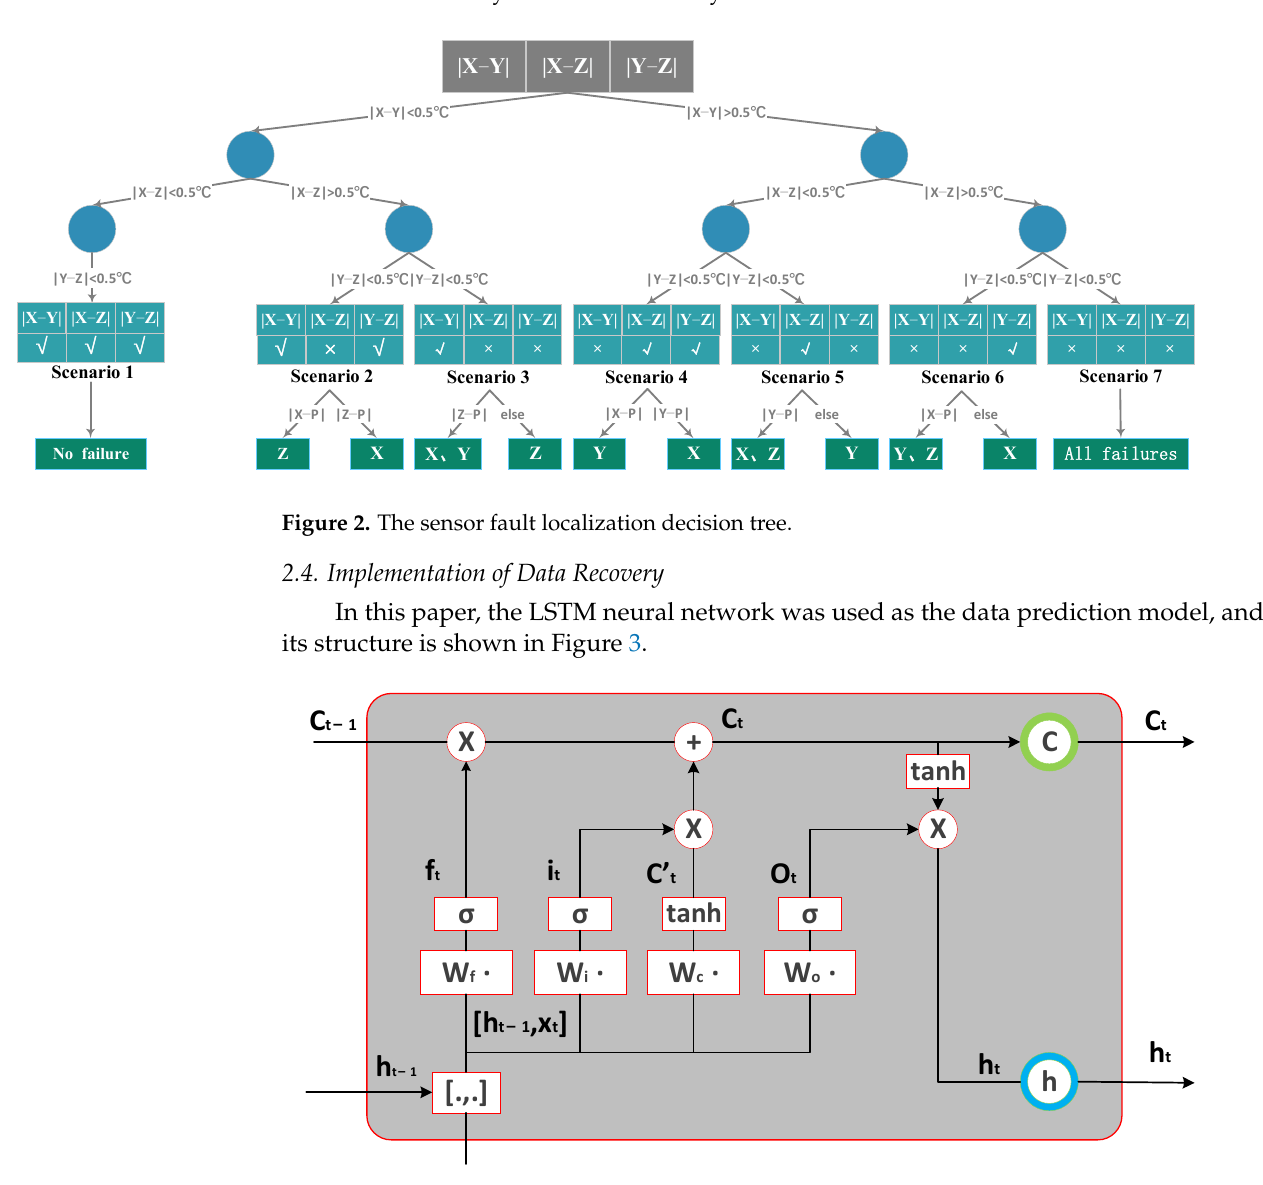
Figure 3. The structure of the LSTM.